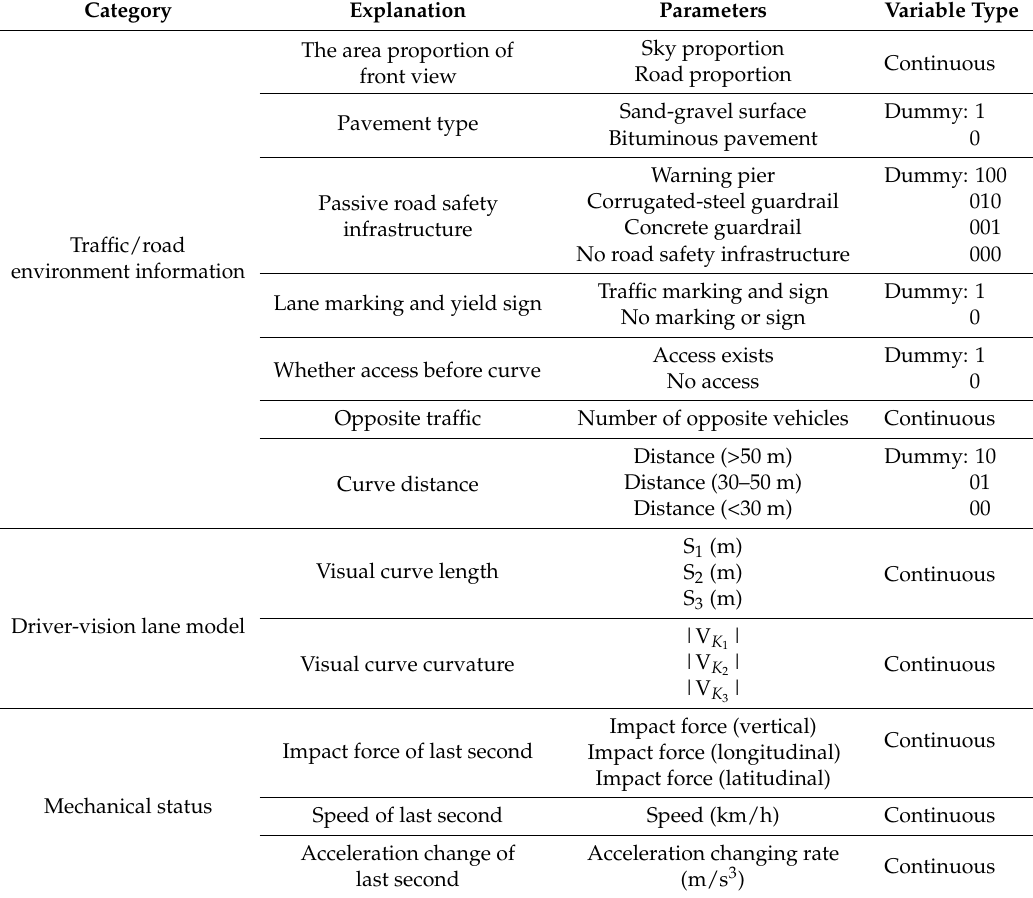
Table 5. Explanation of Parameters Considered in the Prediction